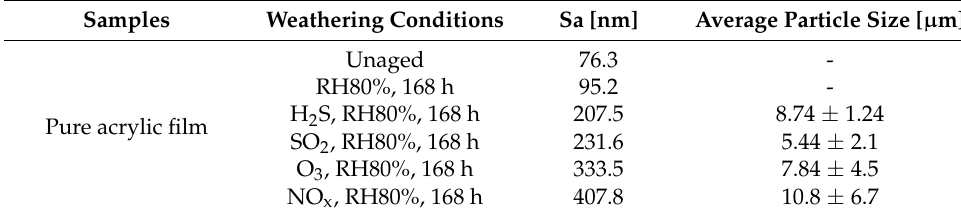
Figure 2. AFM topography images of acrylic films: ( a ) unaged; ( b ) RH 80%; ( c ) H 2 S; ( d ) SO 2 ; ( e ) O 3 ; ( f ) NO x aged. Table 3. AFM roughness values for acrylic films.